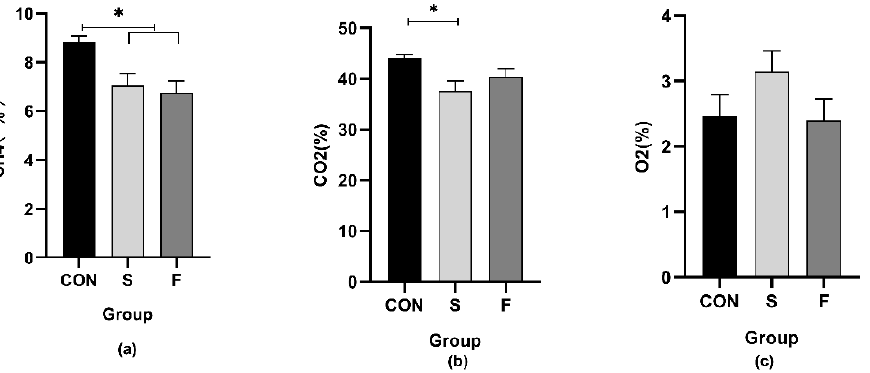
Figure 3. Effects of oilseed treatments on in vitro gas composition (%). ( a ): CH 4 content, ( b ): CO 2 content, ( c ): O 2 content. CON: Control group, S: Diet treated with whole raw soybean, F: Diet